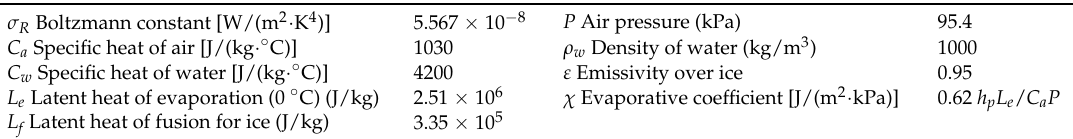
Table 2. Main parameters of the heat balance